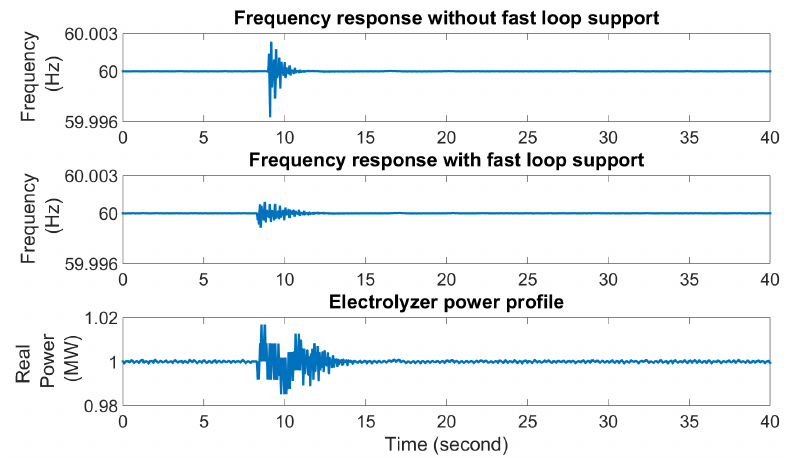
Figure 11. Case study: frequency support from small-scale hydrogen refueling station.